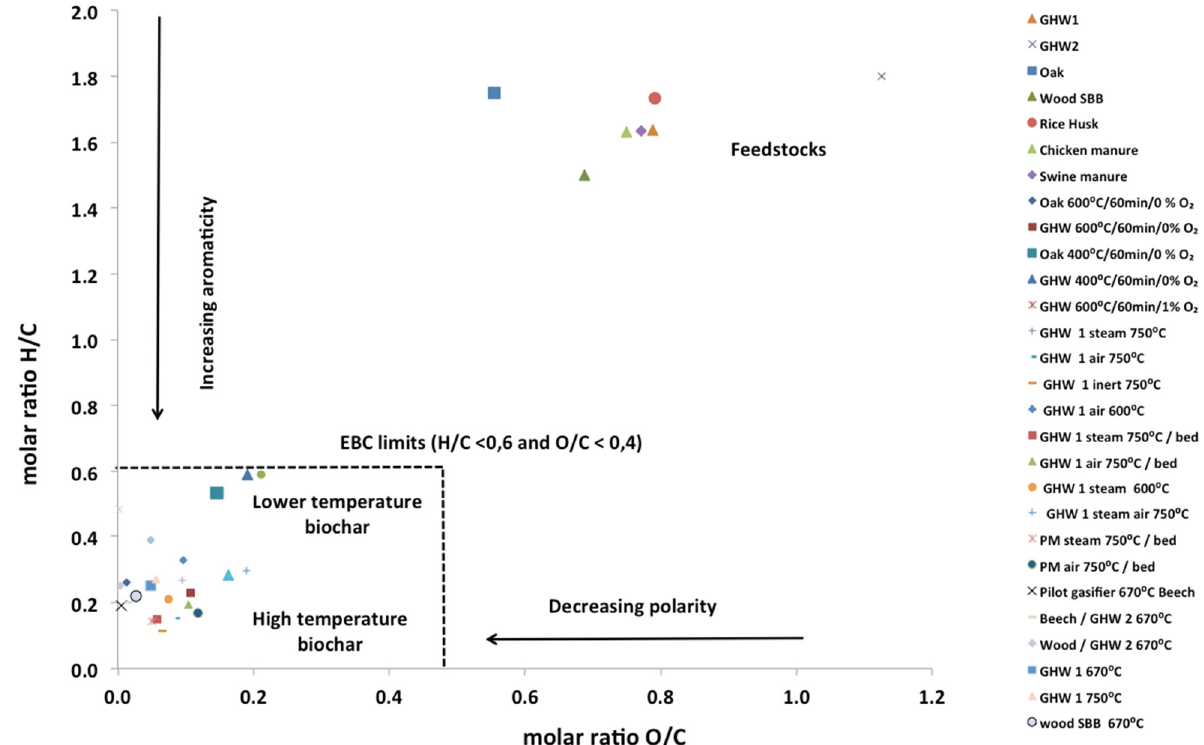
Figure 3. Van Krevelen Diagram of the feedstock and the obtained biochar